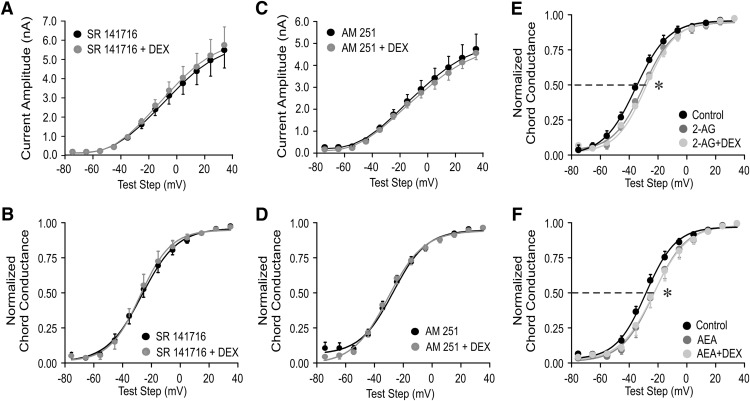
CB1 receptor analogs blocked the glucocorticoid modulation of IA. A, B, The CB1 receptor inverse agonist SR141716 (1 μm) blocked the decrease in IA peak amplitude (A) and the rightward shift in the voltage dependence of activation (normalized chord conductance; B) induced by Dex (1 μm) in PVN magnocellular neurons in slices from salt-loaded rats. C, D, The CB1 receptor inverse agonist am251 also blocked the Dex-induced decrease in IA peak amplitude (C) and the positive shift in activation voltage dependence (normalized chord conductance; D) in PVN magnocellular neurons from salt-loaded rats. E, F, 2-AG (1 μm; E) and AEA (1 μm; F) caused a positive shift in the IA voltage-dependence curve (normalized chord conductance) from the control value, but subsequent application of Dex (1 μm) failed to further shift the curve, suggesting occlusion of the Dex effect by prior CB1 receptor activation. *p < 0.05 with ANOVA. Student’s paired t test.